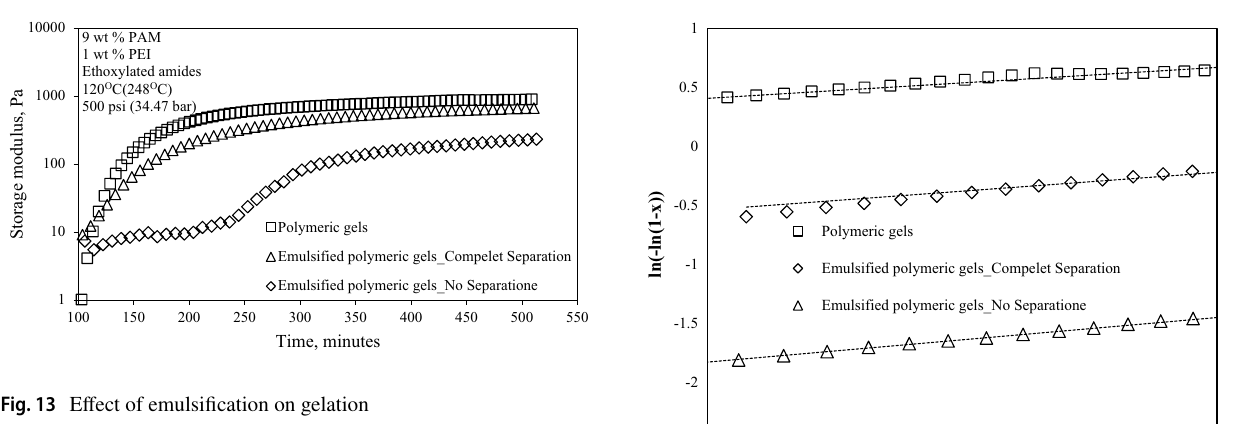
Fig. 13 Effect of emulsification on gelation